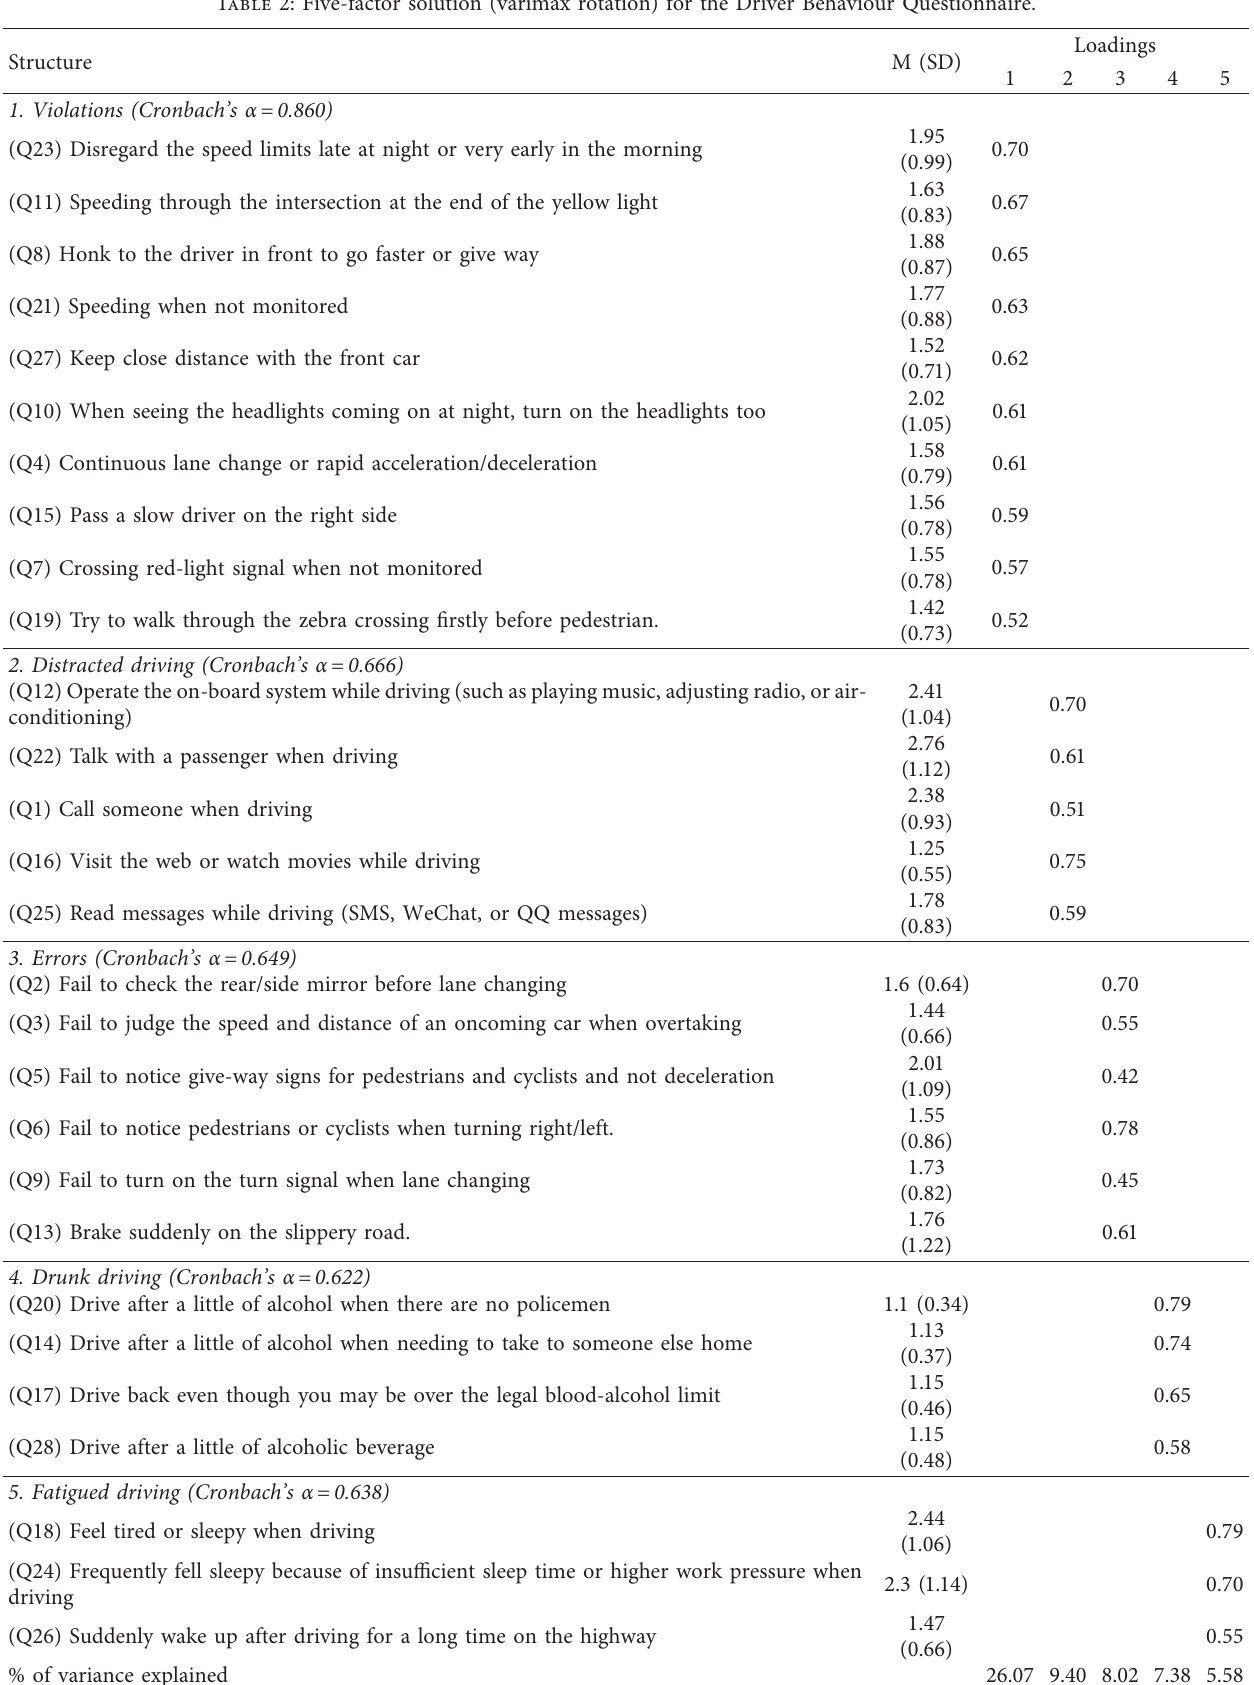
Table 2: Five-factor solution (varimax rotation) for the Driver Behaviour